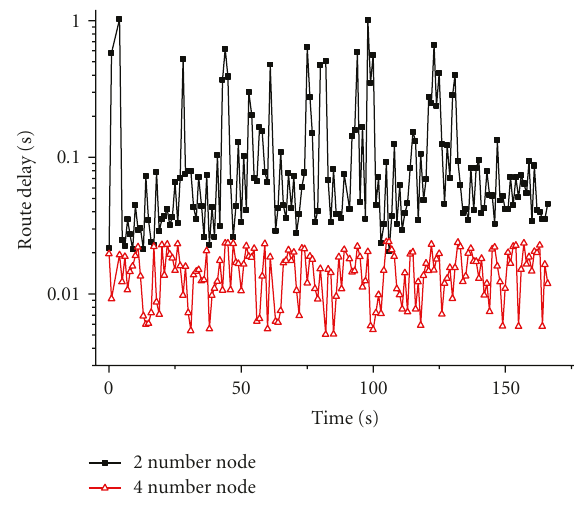
Figure 25: The route delay of